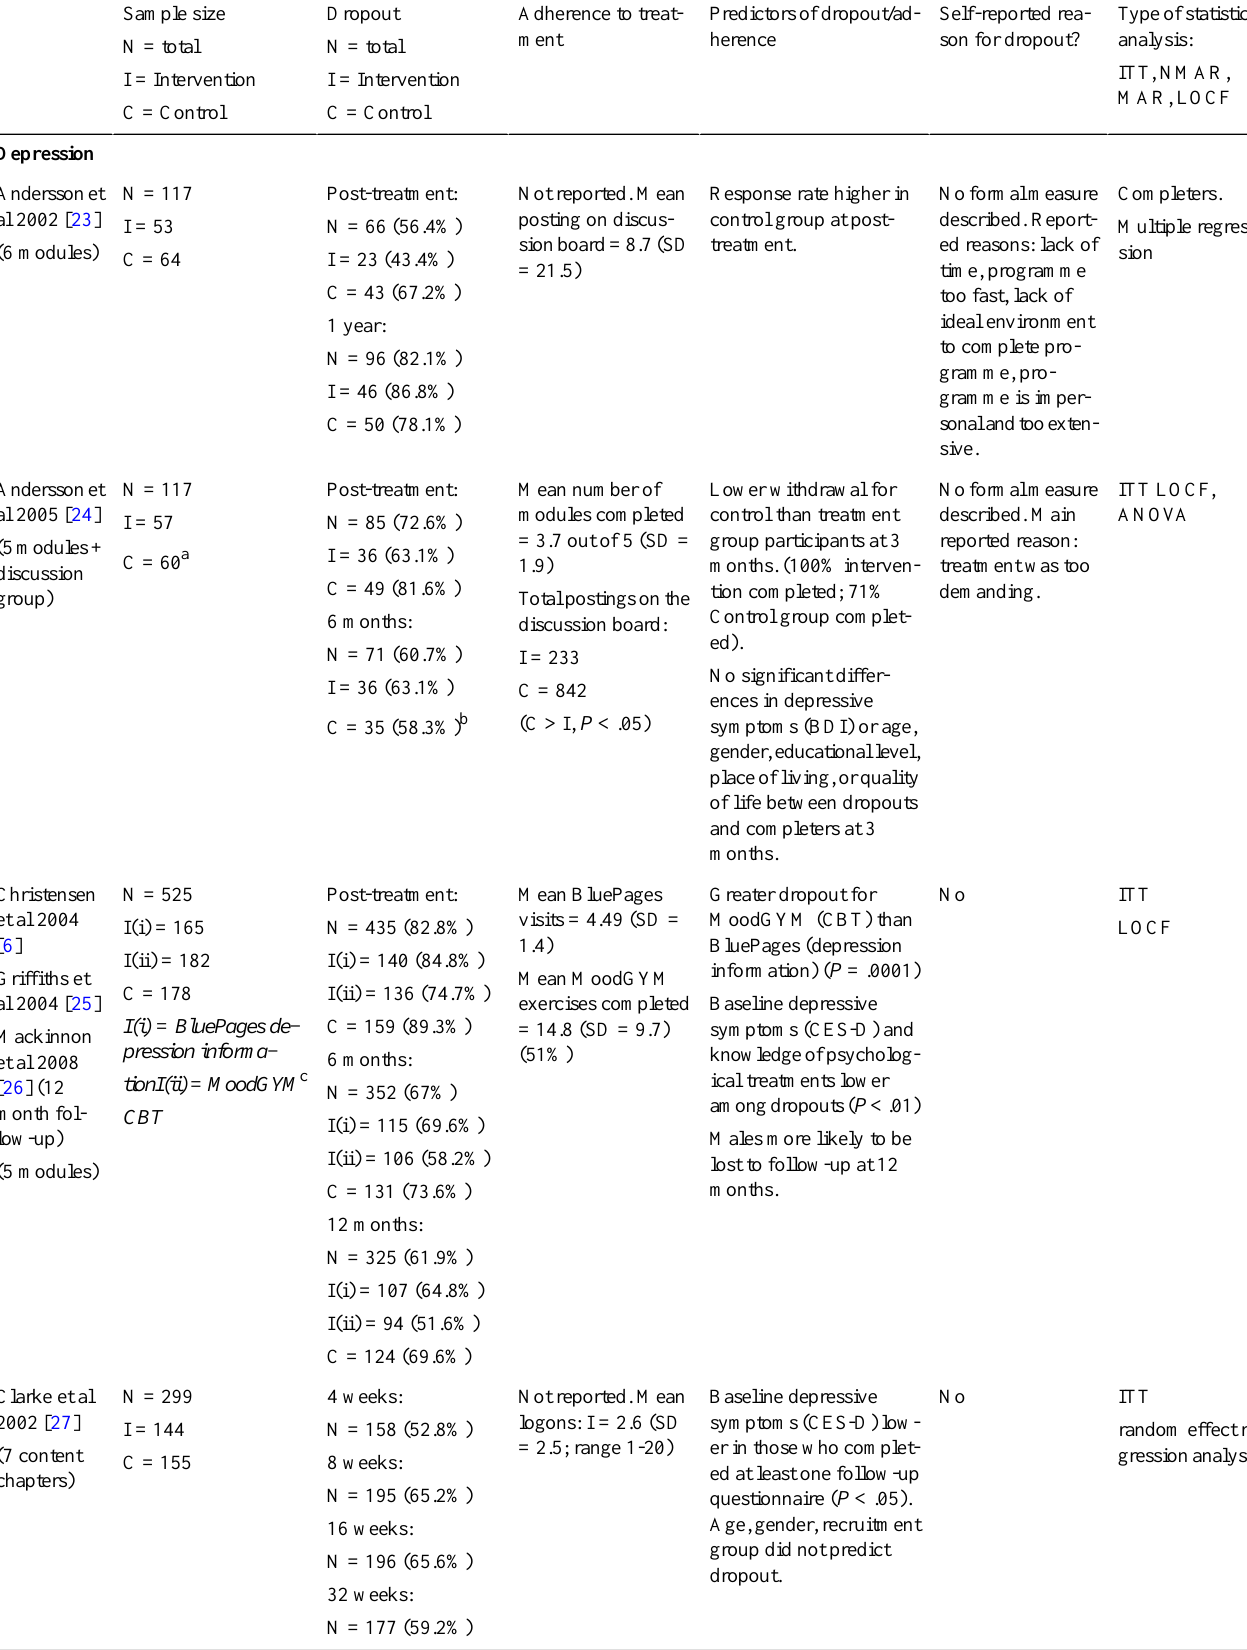
Table 1. Summary of included randomized controlled trials of Internet interventions for anxiety and